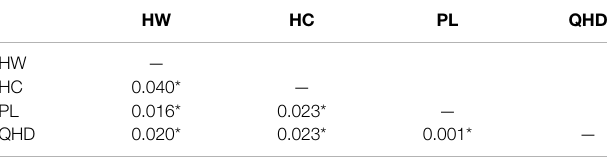
TABLE 5 | Estimates of pairwise F ST values among the four P. trituberculatus